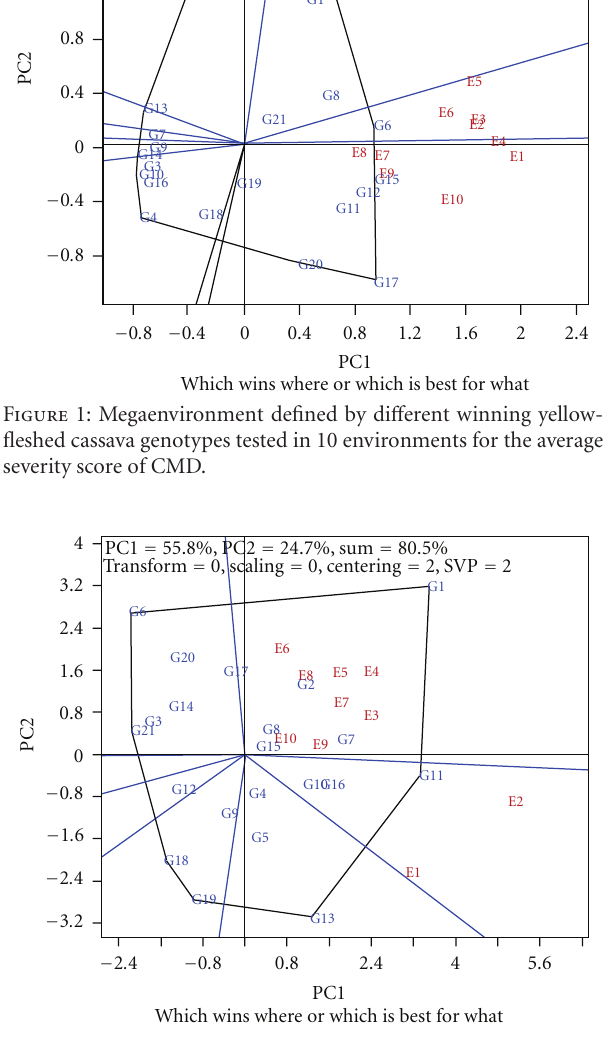
Figure 2: Megaenvironments defined by di ff erent winning yellow- fleshed cassava genotypes tested in 10 environments for the average FYLD (tha − 1 ).